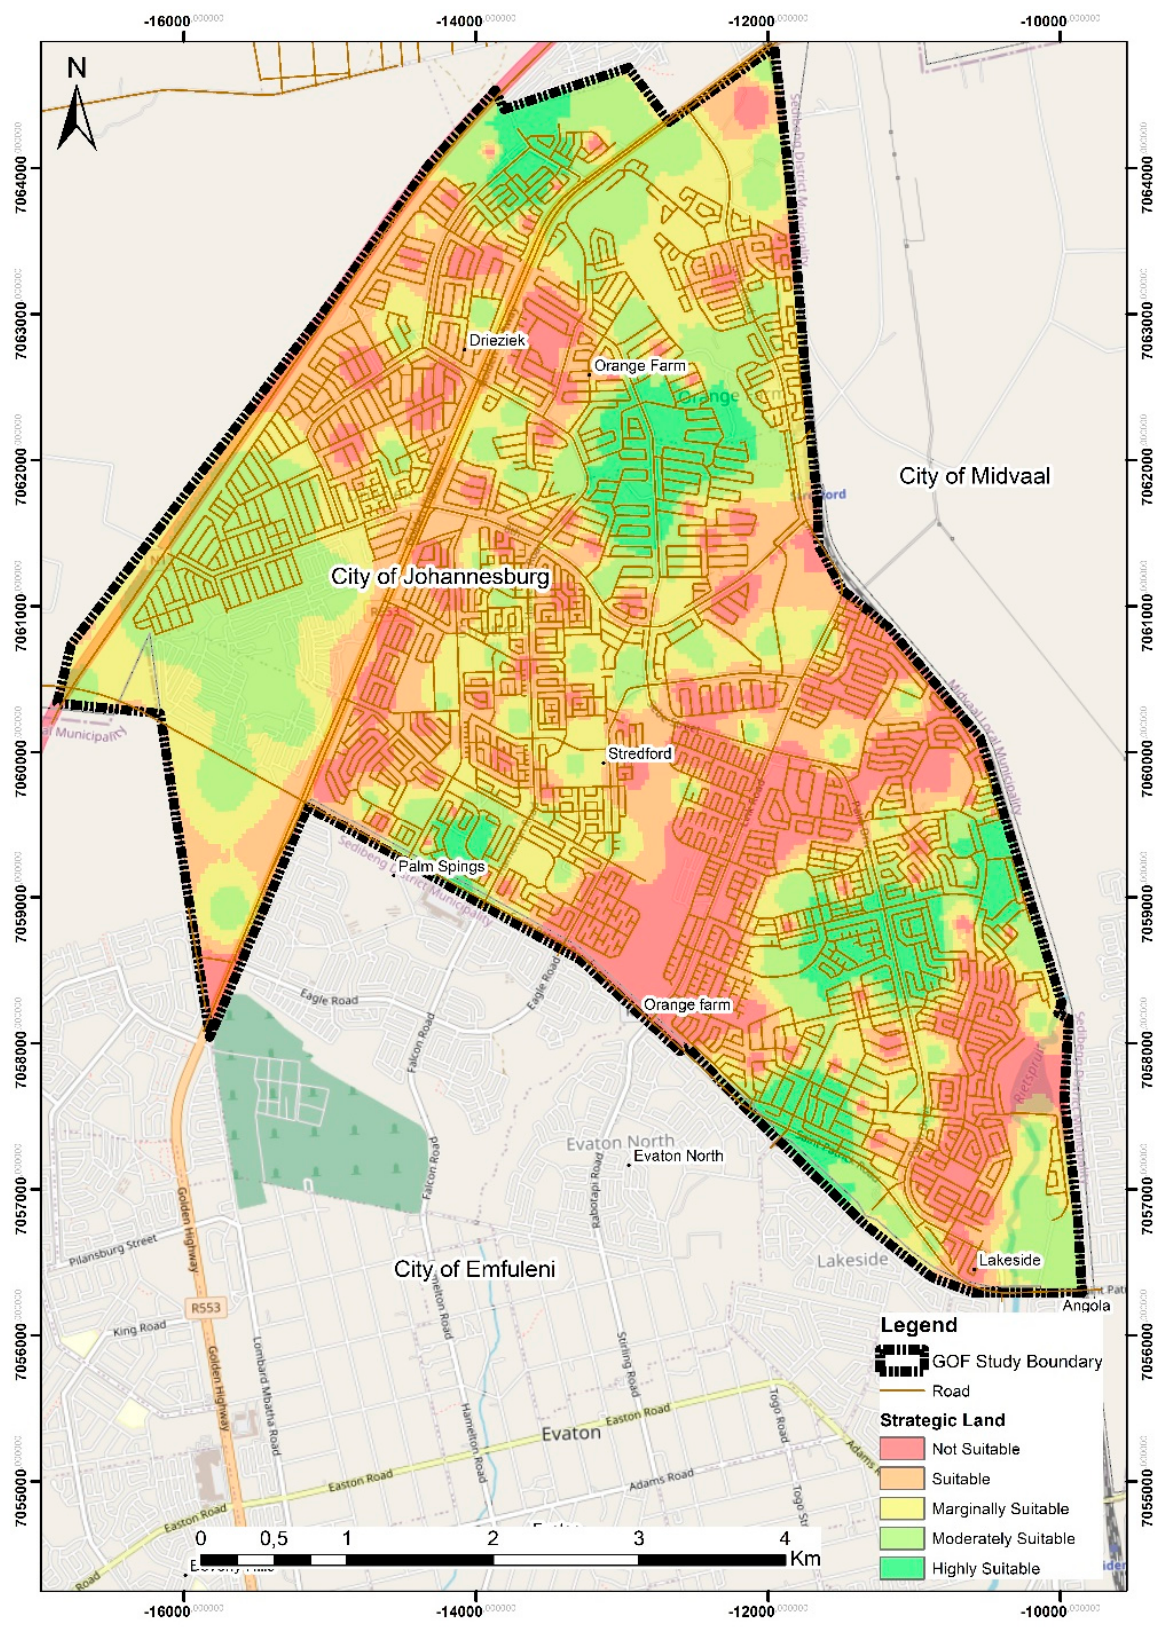
Figure 5. Strategic land for urban agriculture in GOF.